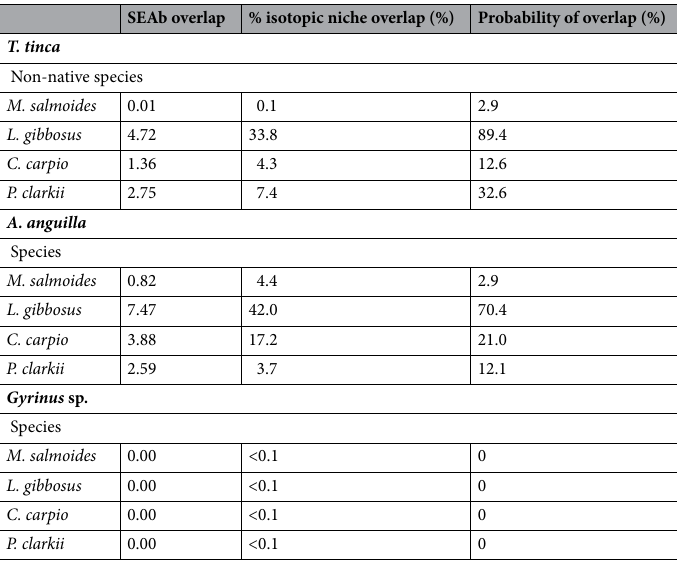
Table 3. SEAb overlap among non-native species in Arreo Lake and T. tinca, A. anguilla, and Gyrinus sp. as well as the probability of t hese to occur in the niche of respective non-native species.